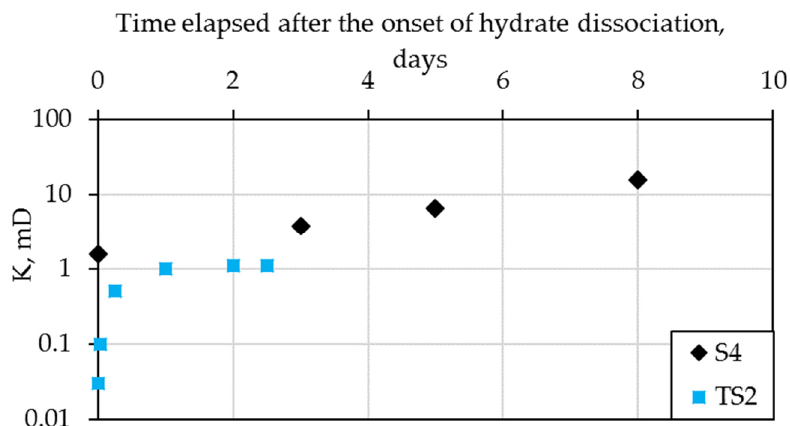
Figure 8. Gas permeability of frozen hydrate-bearing sand S4 and TS2 at non-equilibrium pressure and − 5 °C. Hydrate dissociation at 0.1 MPa (up to 3 days) and 3 MPa, after nitrogen injection to 3 MPa (after 3 days).